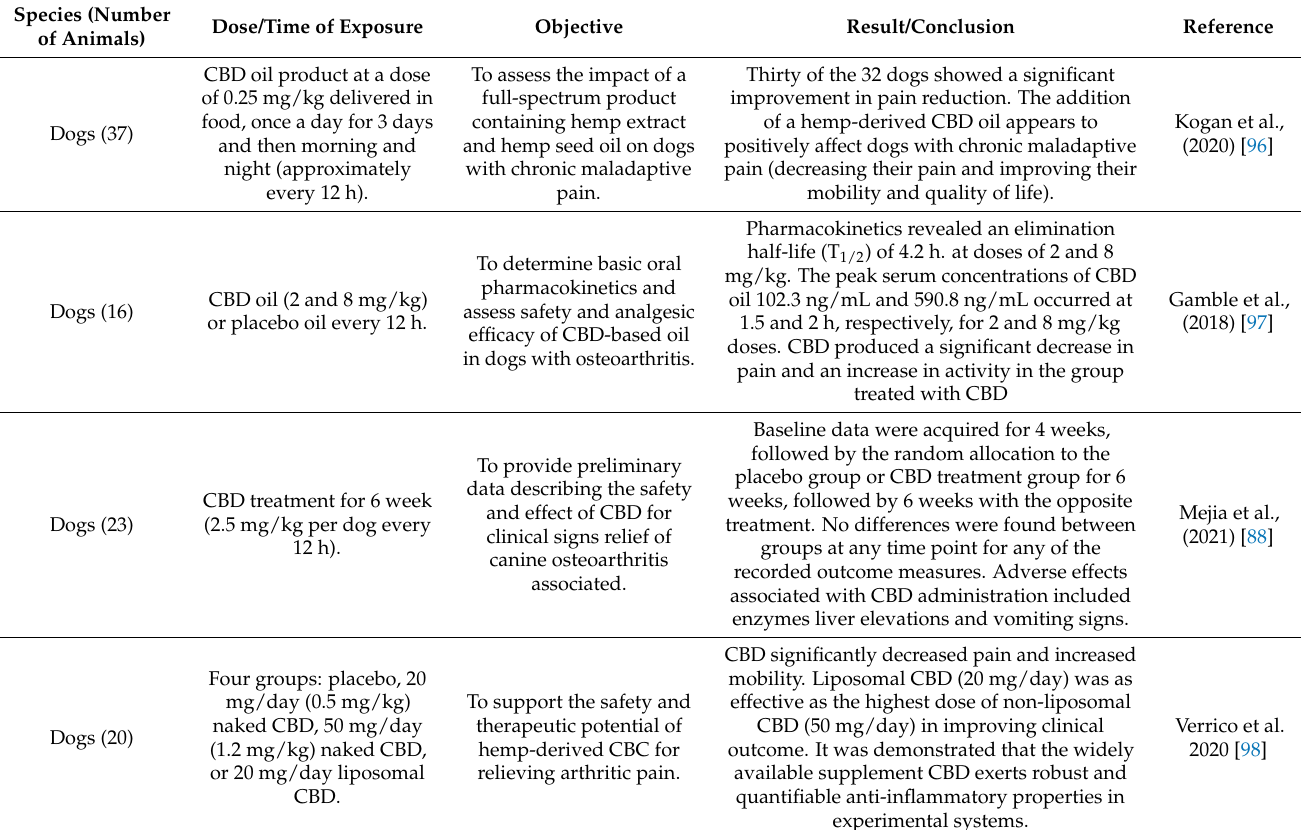
Table 2. Non-exhaustive listing of CBD studies on dogs and